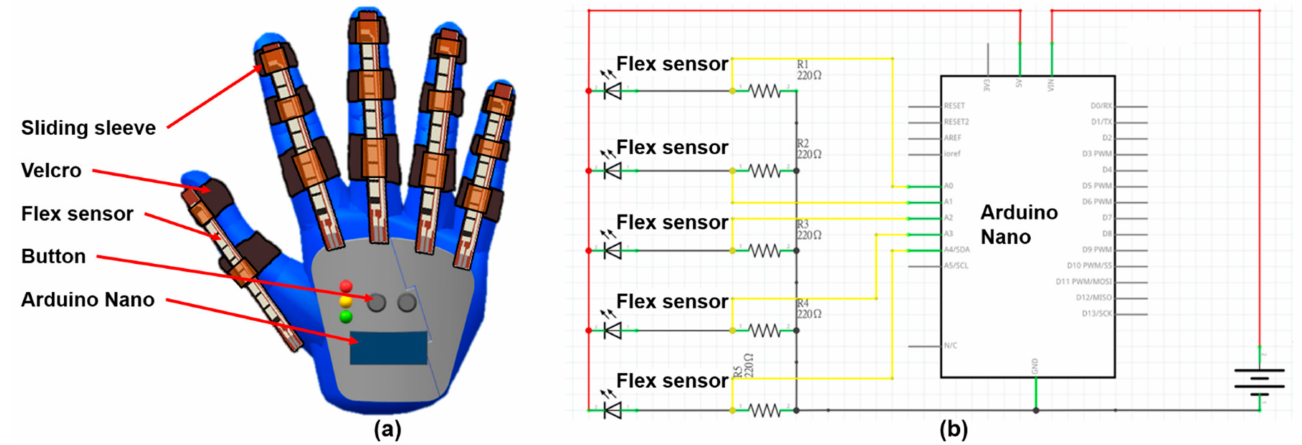
Figure 6. ( a ) Hand-sensing glove; ( b ) electronic circuits of the hand-sensing